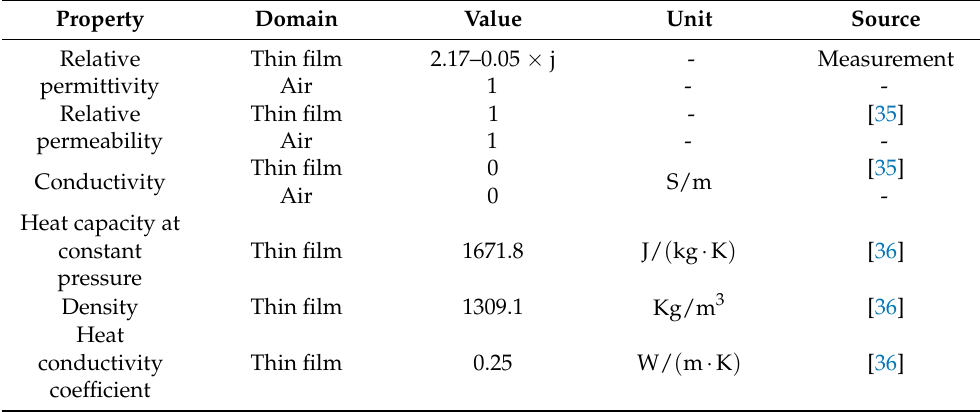
Table 2. Related input parameters of the